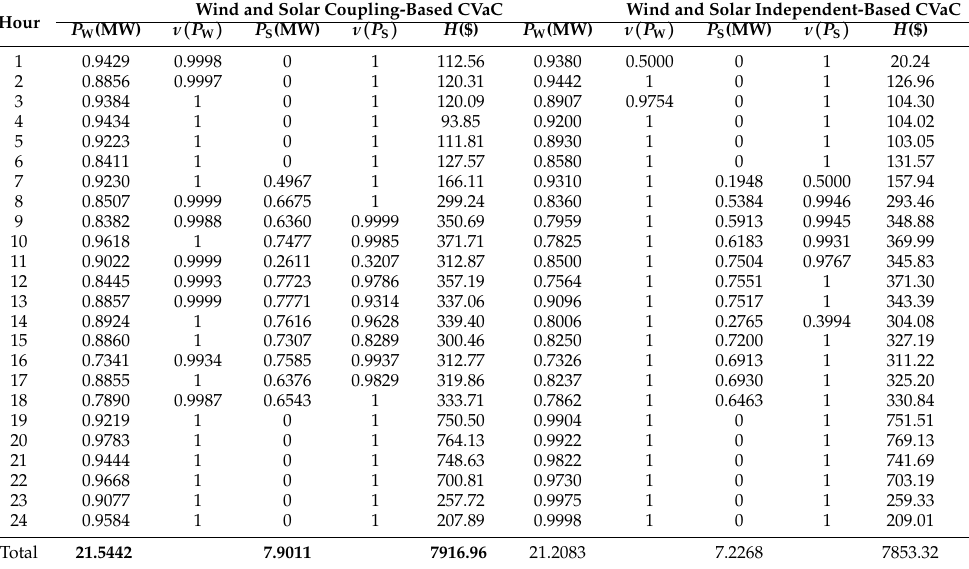
Table 4. Comparison results between CVaC with and without wind/solar coupling.